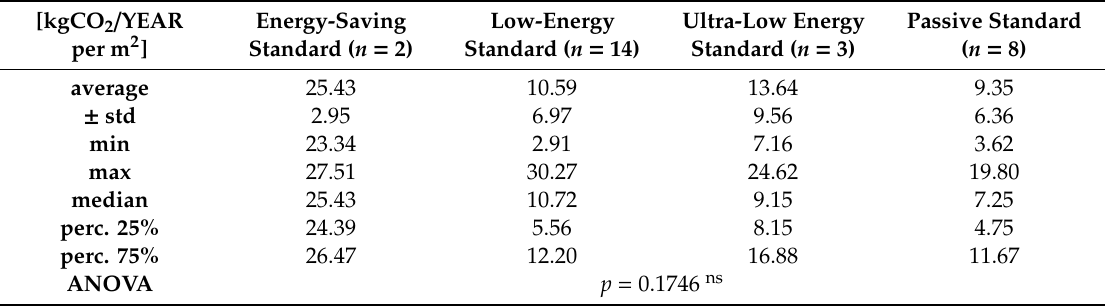
Table 7. Annual CO 2 production in relation to heating categorized according to energy standards calculated per m 2 of useful floor area of the analyzed column wood